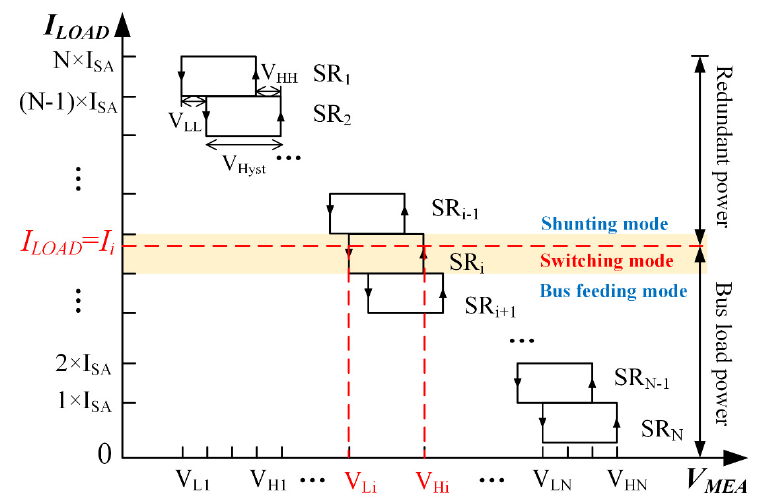
Figure 3. Relationship between V MEA and the load current.